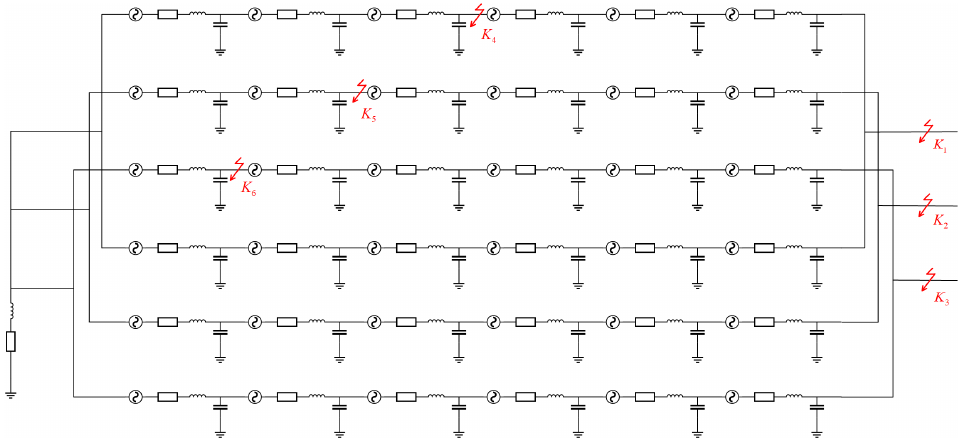
Figure A1. Schematic diagram of overall structure and fault location of 660-MW turbo-generator model.